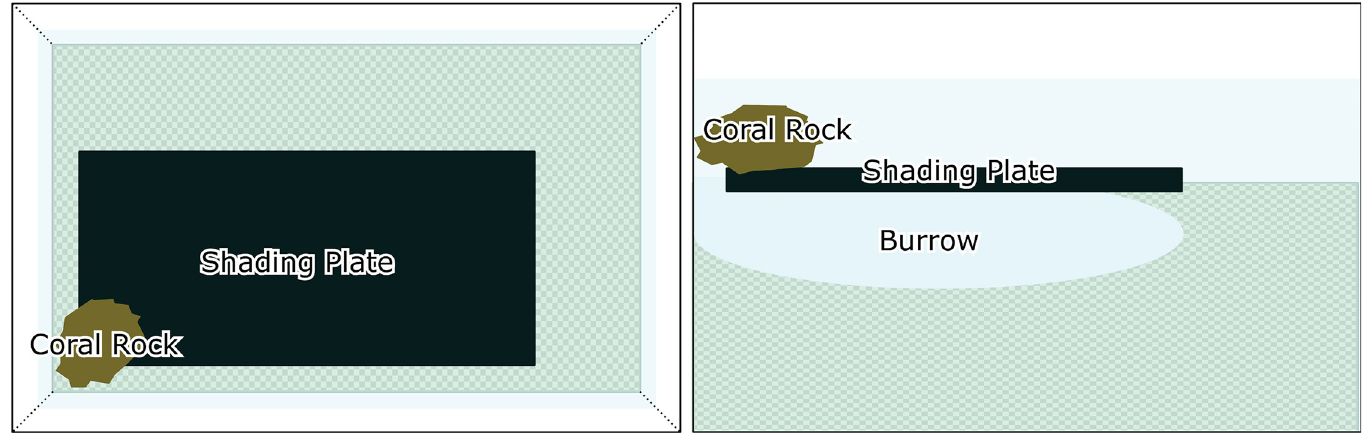
Fig 2. Schematic diagram of an experimental tank. The left and right panels show top and side views, respectively.